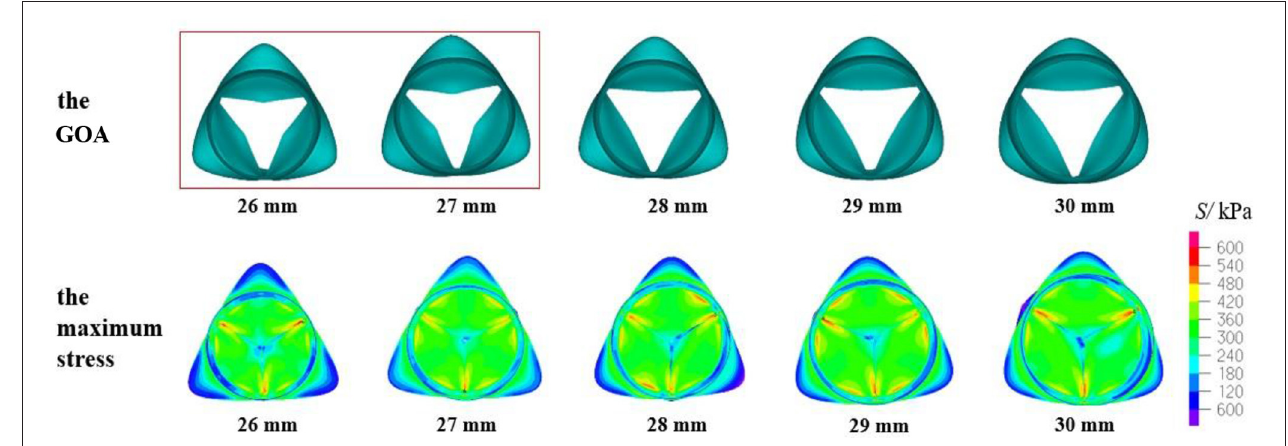
FIGURE 10 | GOA of the valve and maximum stress distribution of the model with H V = 15mm and D AA of